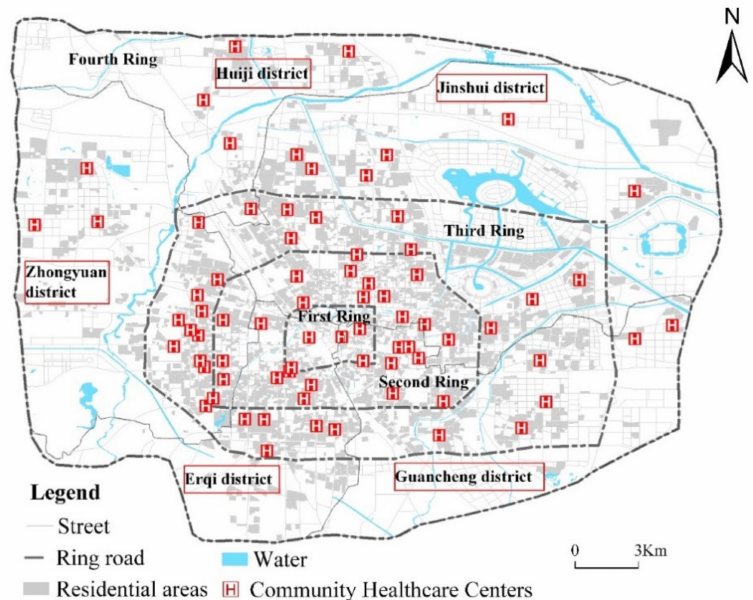
Figure 1. Study area (created by the authors).